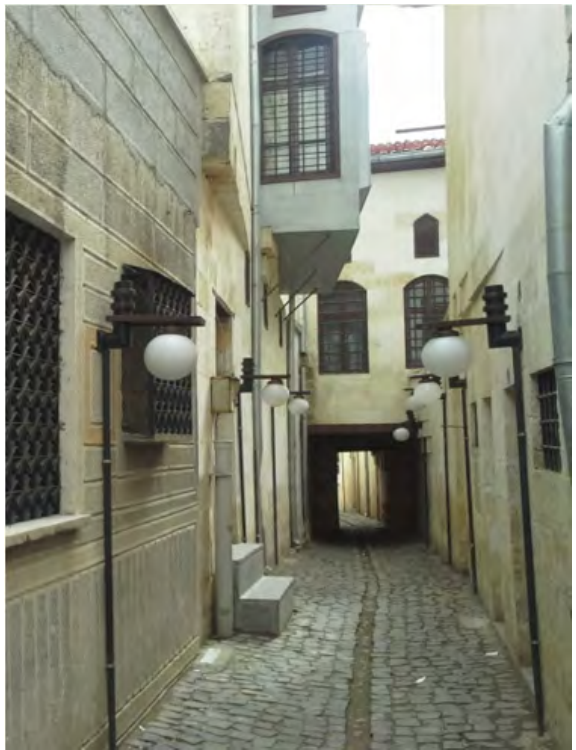
Figure 6. Passage example which is called ’Kabaltı’